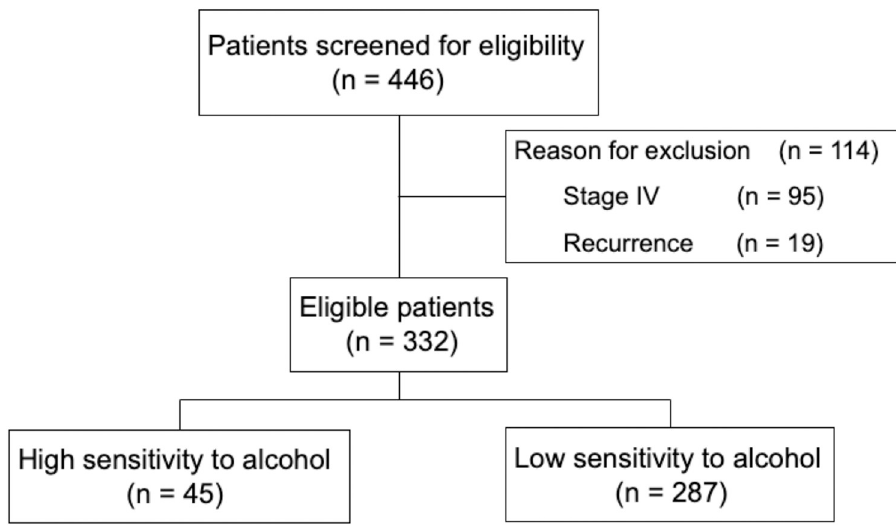
Fig 1. Flow diagram of the patients included in the